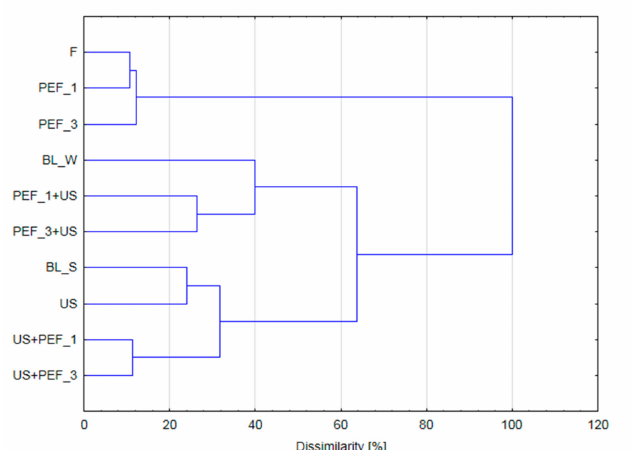
Figure 5. PCA for fresh (F) red bell pepper and subjected to traditional (blanching in water, BL_W, and blanching in steam, BL_S) and non-thermal single treatment (US—ultrasound, PEF_1 and PEF_3—pulsed electric field with energy input 1 and 3 kJ / kg, respectively) and combined treatment (PEF + US and US +